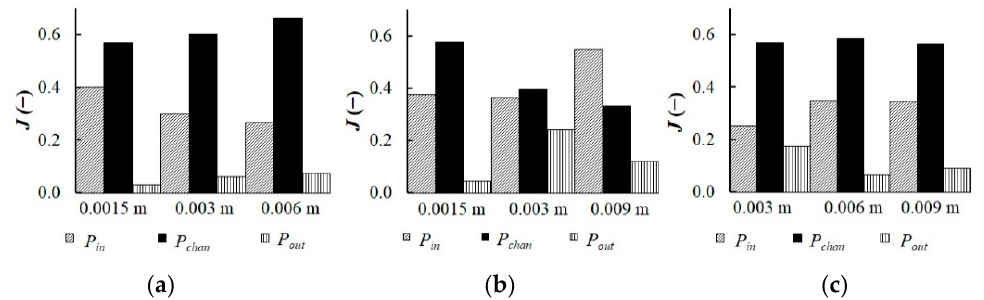
Figure 12. Share of the head loss of the total pressure drop at different swirler channel widths and at h = 0.008 (m): ( a ) straight channels n = 32 (pcs); ( b ) profile channels n = 40 (pcs); ( c ) annular channels n = 8 (pcs).